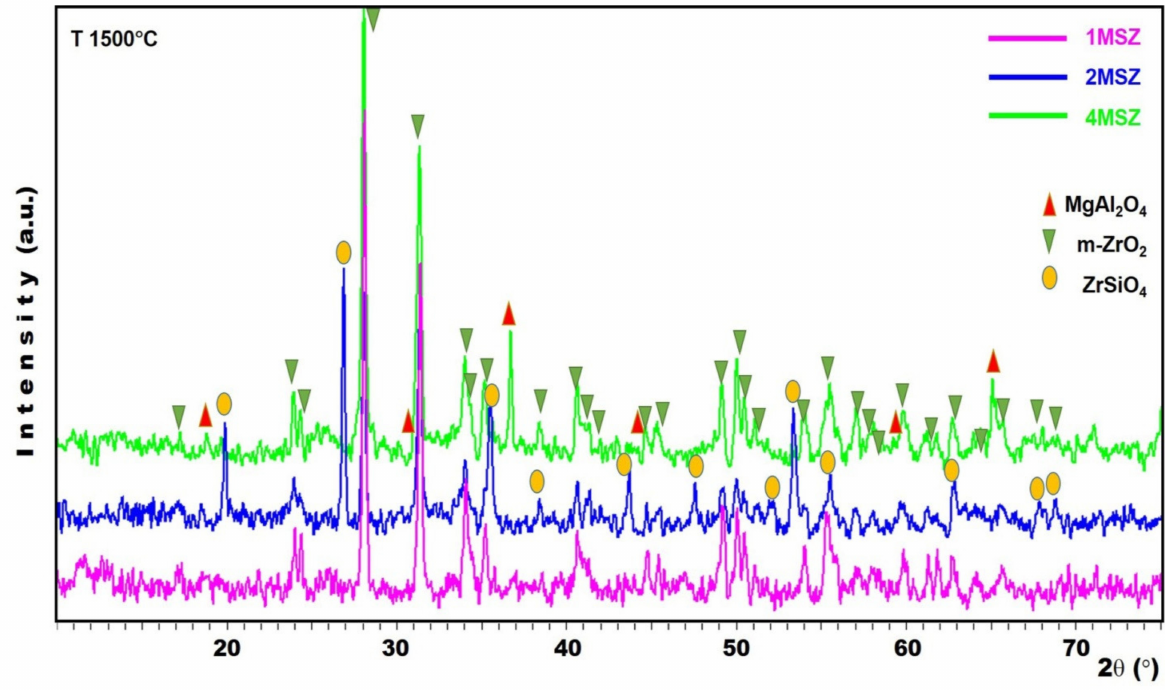
Figure 6. The XRD diffractograms of the sintered MSZ samples at 1500 ◦ C.